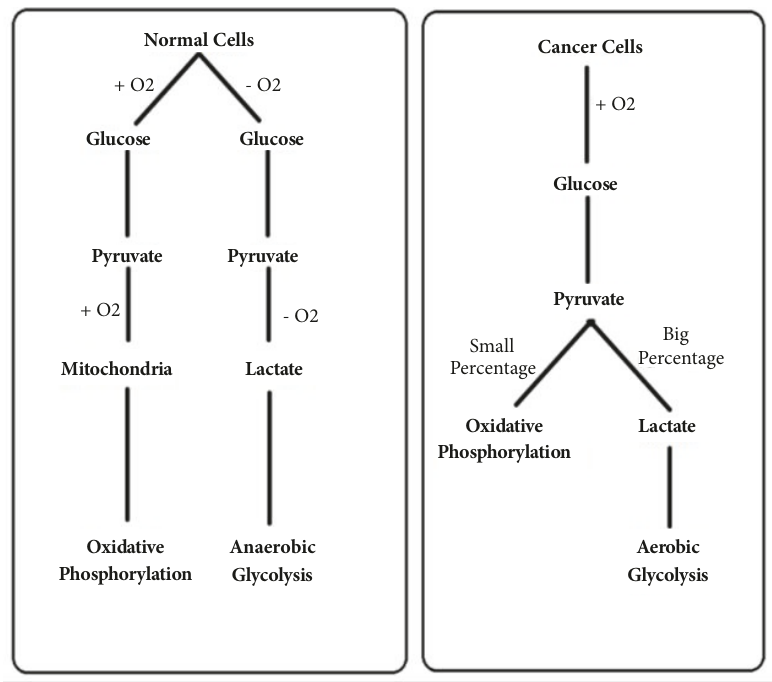
Figure 3: Comparison in the metabolism pathway between normal cells and neoplastic